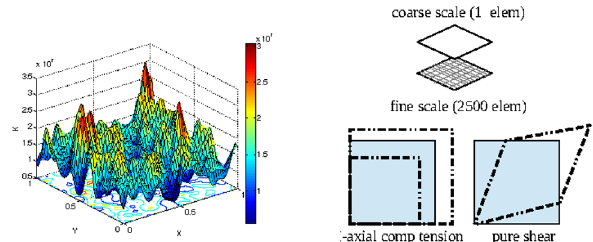
Fig. 6 Upscaling of elastic properties. Left: random realization of bulk modulus. Right: upscaling